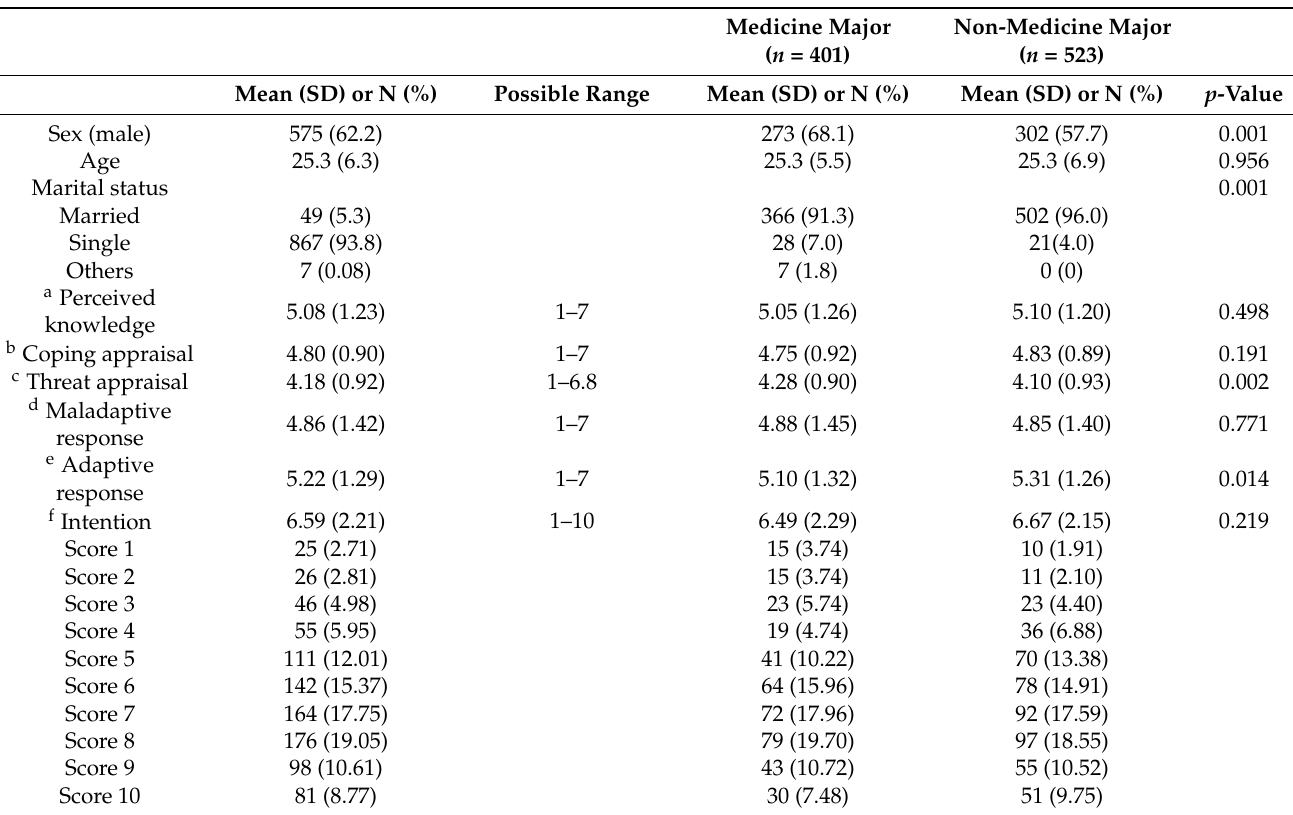
Table 2. Characteristics of participants ( n =